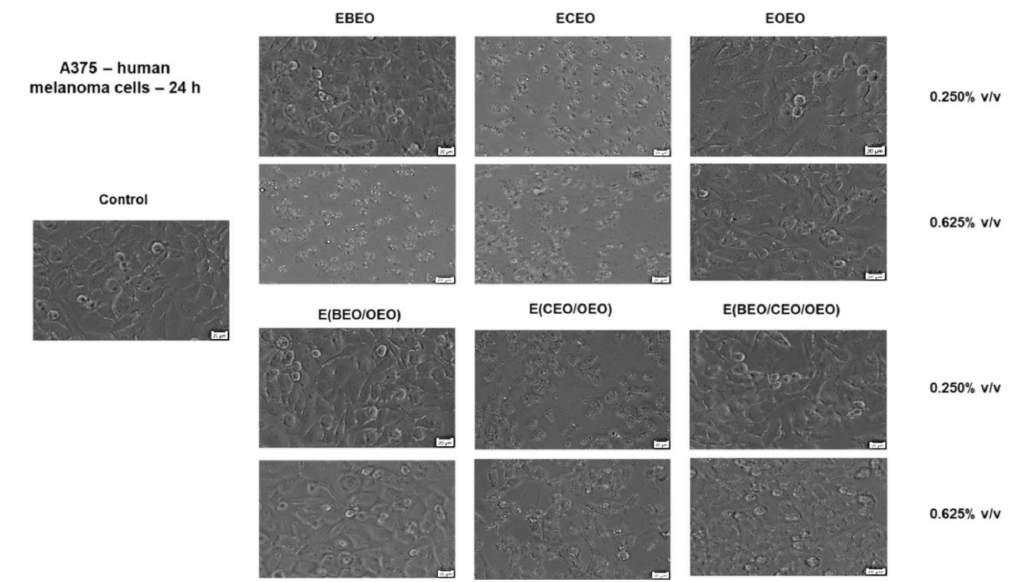
Figure 6. The morphological aspect of A375 cells in culture: Control—unstimulated cells and cells stimulated with different test compounds: ECEO, EOEO, EBEO, E(BEO/OEO), E(CEO/OEO), and E(BEO/CEO/OEO) for 24 h. The scale bar is 20 µ